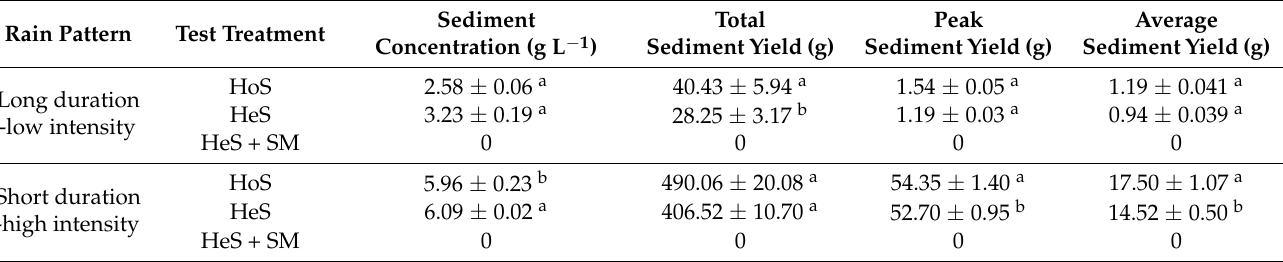
Table 4. Effect of straw mulching on soil loss in red soil sloping